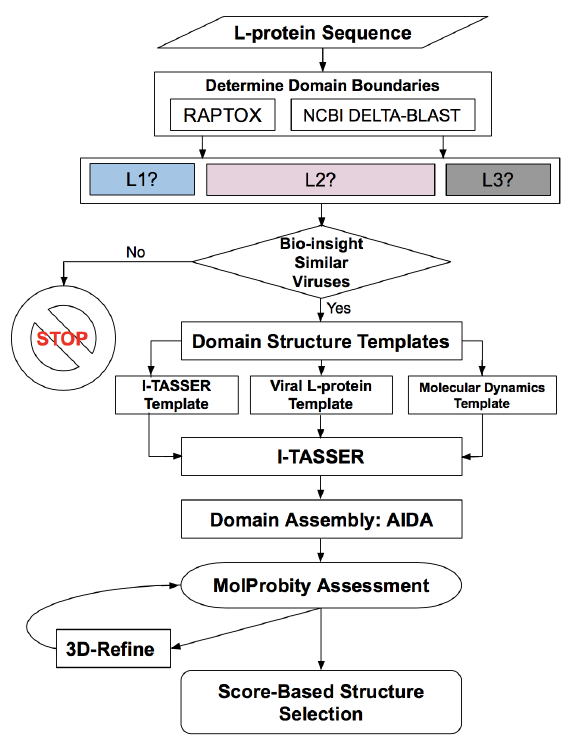
Figure 1. Workflow for determining the protein domains, domain boundaries, domain structure, domain assembly, evaluation and refinement of the Rift Valley fever virus (RVFV) L protein containing 2092 amino acids.